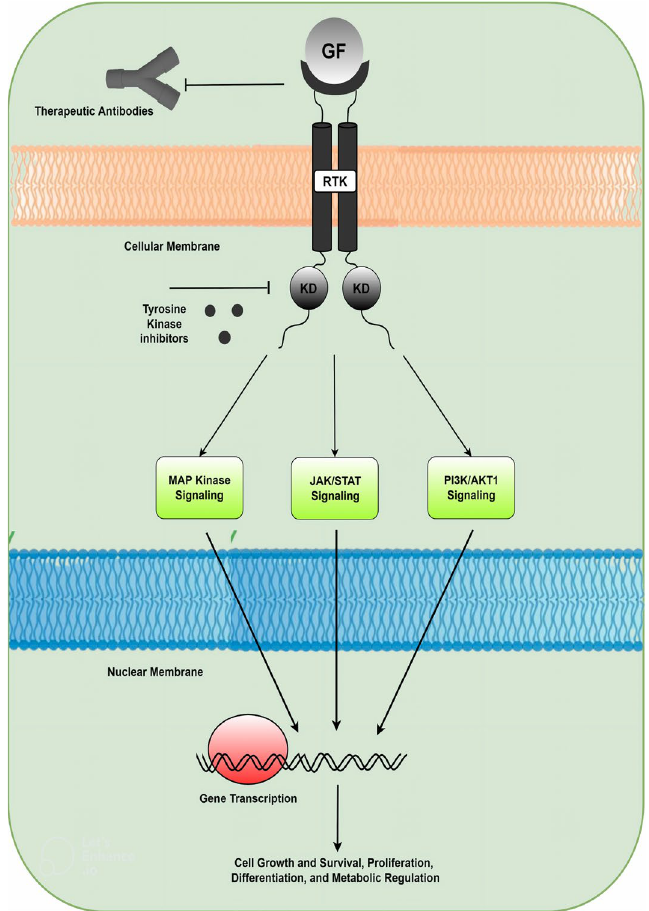
Figure 1. Binding of Growth Factor (GF) to